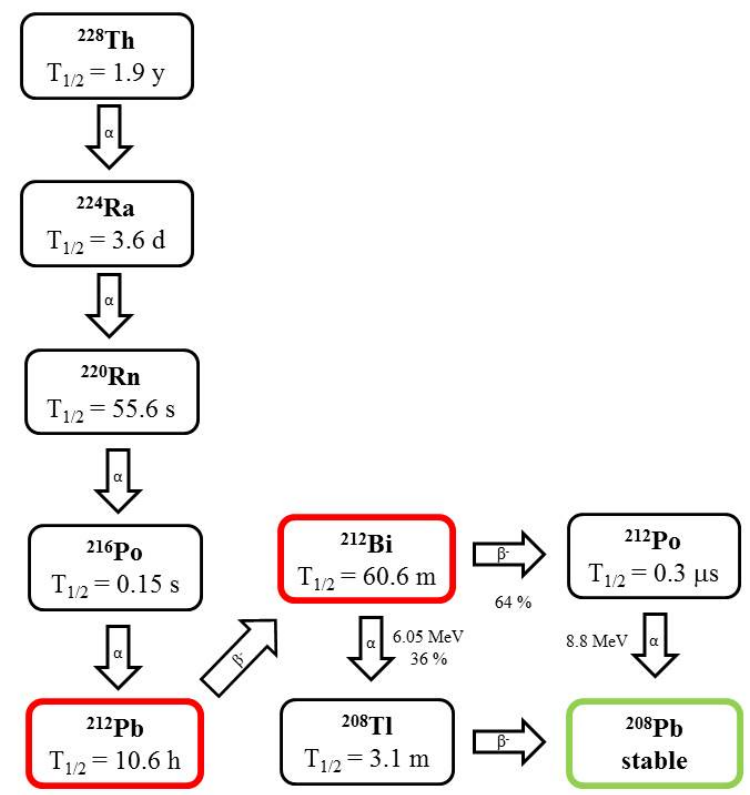
Figure 3. Decay scheme of 212 Bi and 212 Pb.